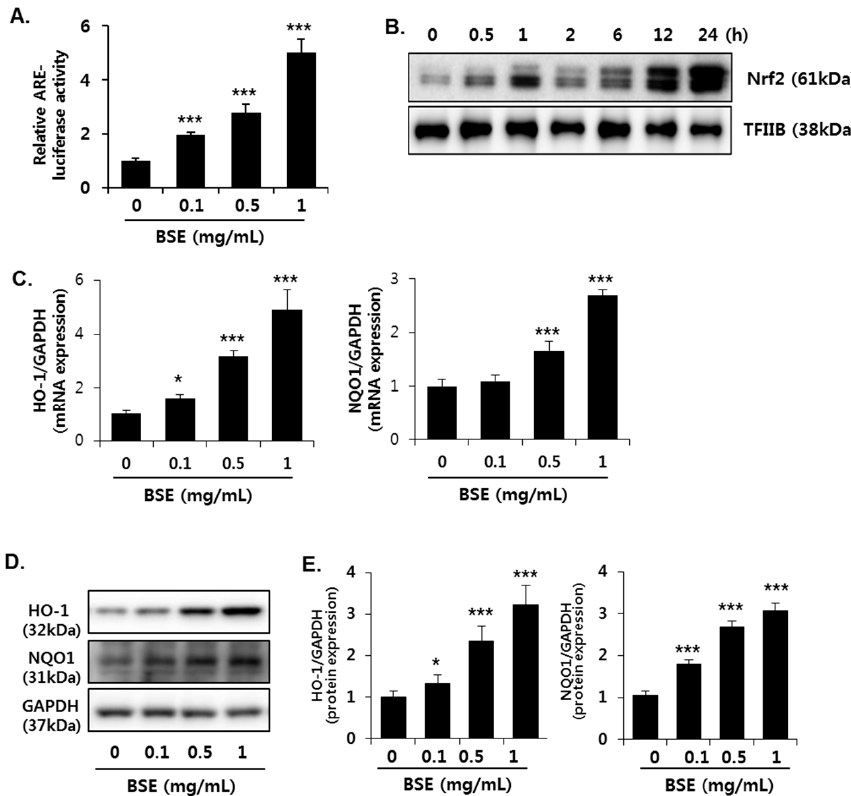
Figure 7. Induction of Nrf2 activity in HepG2 cells by barley sprout extract (BSE). ( A ) Cells were exposed to indicate concentrations of BSE for 12 h, and Nrf2 transactivation was determined by ARE-luciferase activity; ( B ) cells were exposed to BSE (1 mg/mL) for 24 h, and Nrf2 protein expression in the nucleus was determined by Western blotting. TFIIB was used as a loading control of nuclear fraction; cells were exposed to indicate concentrations of BSE for 18 h, followed by ( C ) determination of HO-1 and NQO-1 gene expression using real-time PCR; ( D ) visualization of HO-1 and NQO1 protein expression; and ( E ) quantification of their protein levels. Quantitative analysis of the target genes and blots normalized by GAPDH expression. Each value represents the mean ± SD. * and *** Significantly different from vehicle-treated control cells at p < 0.05 and < 0.001, respectively (Student’s t -test).